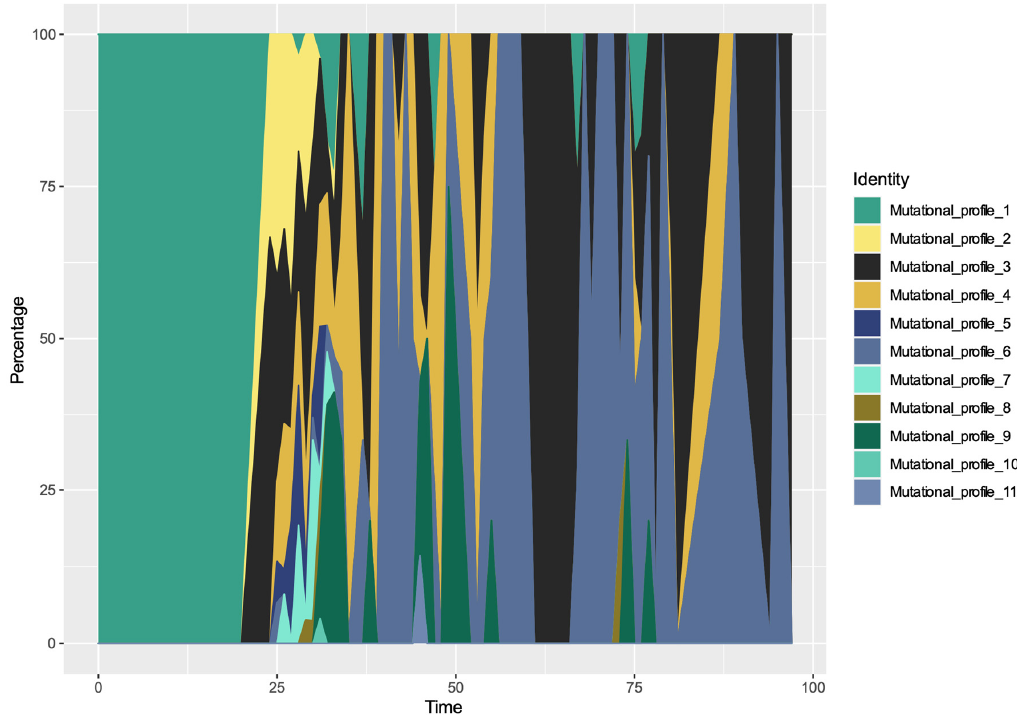
Figure 1. Population dynamics of Swedish SARS-CoV-2 mutational profile over the time. A Muller plot revealed 11 mutational profiles of SARS-CoV-2 in Sweden.